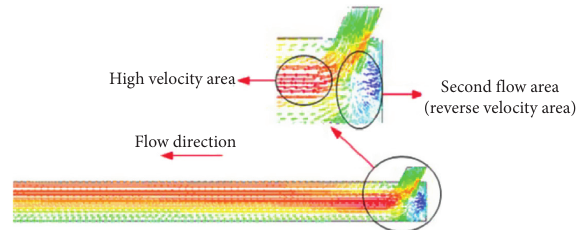
Figure 10: The gas phase flow vector of drilling bit-rod integral structure of 0 ∼ 0.5m.